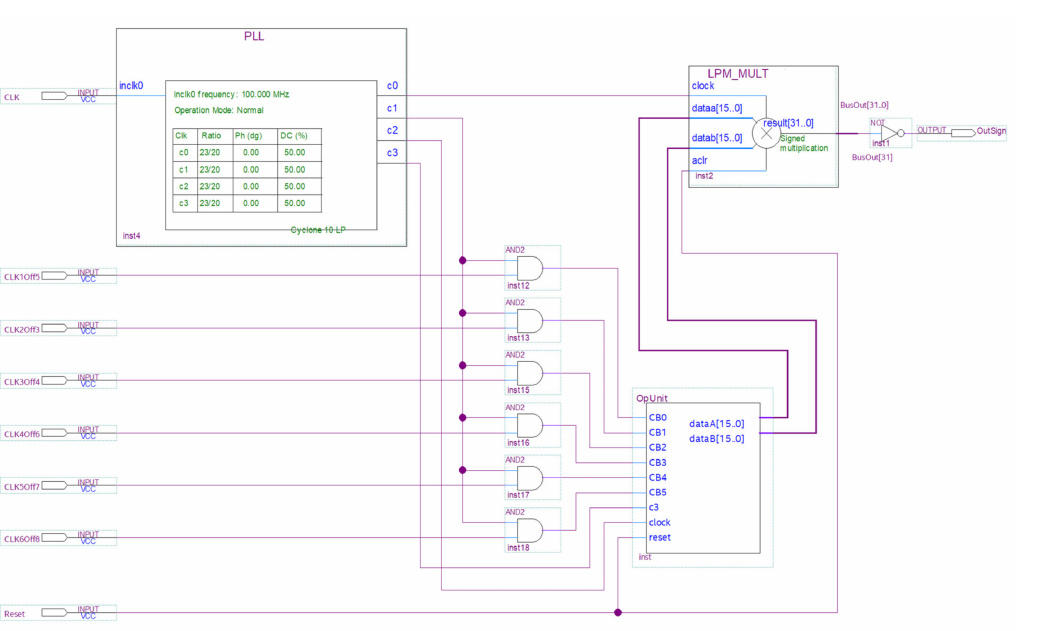
Figure 4. Experimental scheme for n =